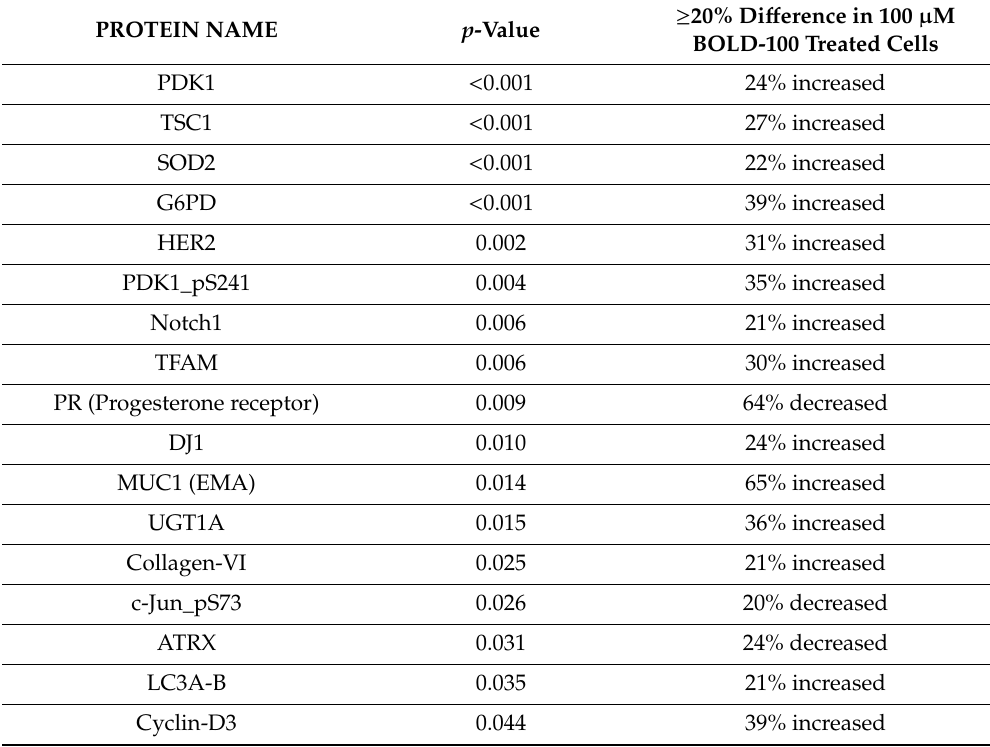
Table 1. Reserve phase protein array (RPPA) results with significantly altered proteins in MCF7 cells treated with 100 µ M BOLD-100 compared with